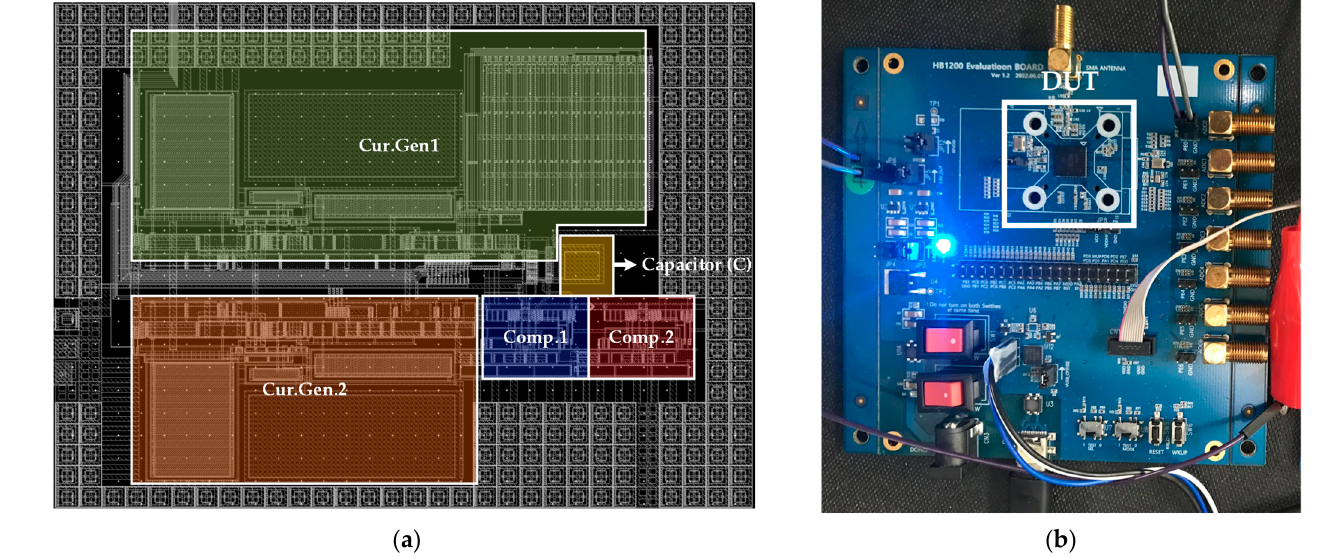
Figure 7. ( a ) Top layout of the proposed relaxation oscillator, and ( b ) DUT.